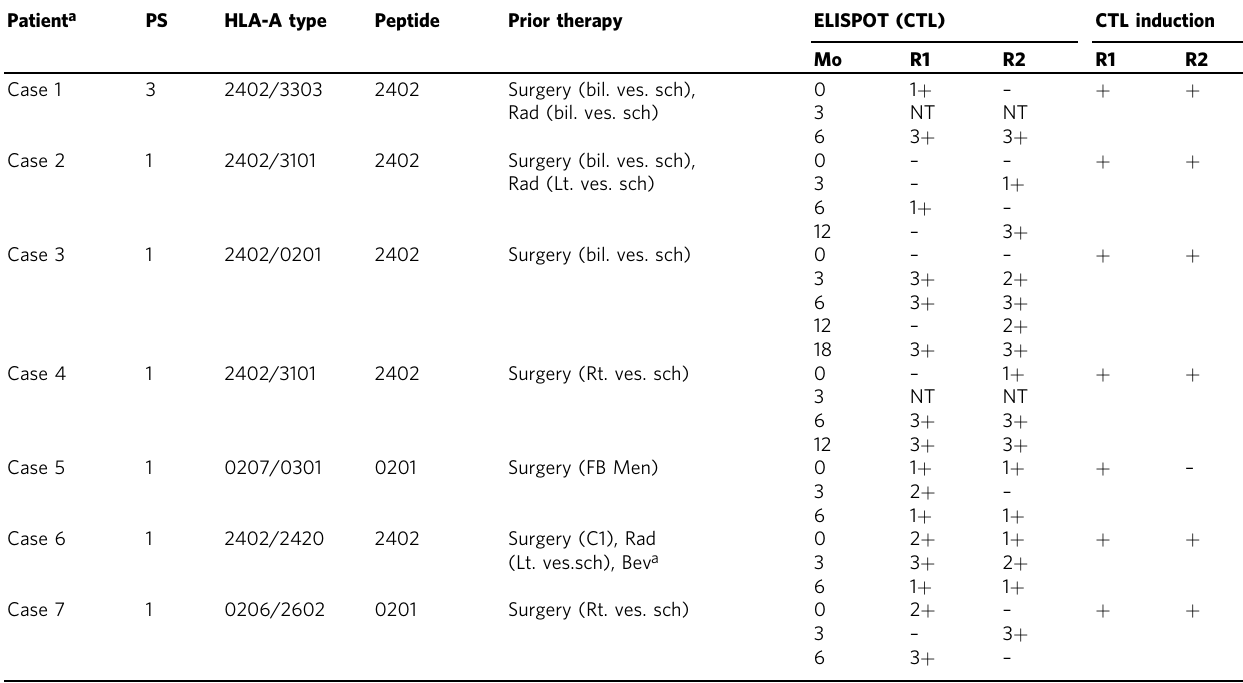
Table 1 Patient